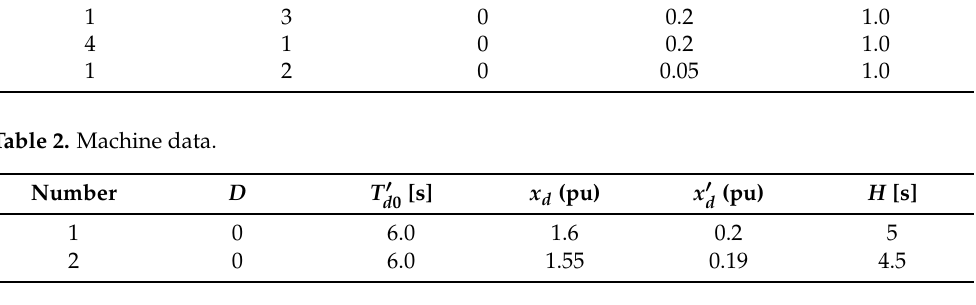
Table 3. Constant values used in Equations (18) and